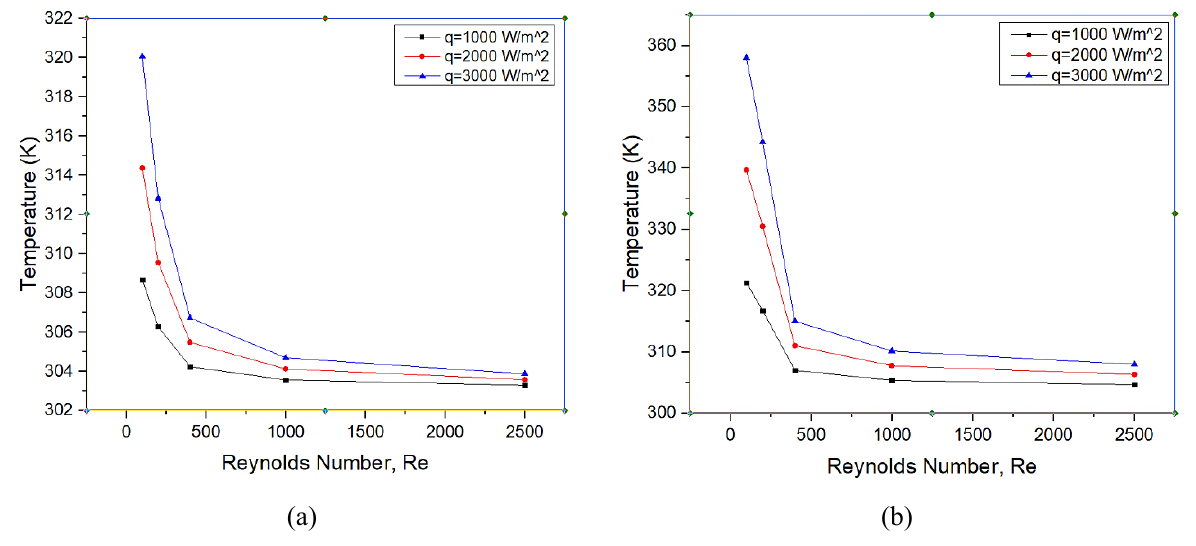
Fig. 7. Variation of (a) outlet stream temp (b) outlet wall temperature with Reynolds Number.